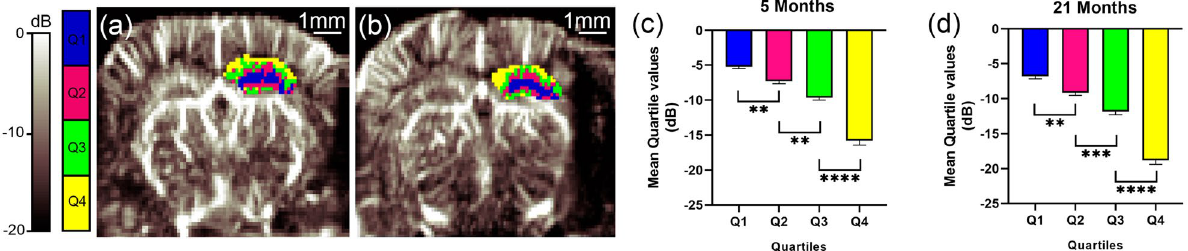
Figure 2. µ Doppler segmentation of the hippocampus. Coronal µ Doppler image in decibels (dB) of a ( a ) 5-month-old and ( b ) 21-month-old mouse. For the dB scale, the reference value was taken as the maximum intensity within left hippocampus. The right hippocampus is overlaid with the quartile distribution of the flow intensity. Blue, fuchsia, green and yellow corresponds to pixels within the quartiles Q1, Q2, Q3 and Q4, respectively. The mean quartiles values showed significant differences between all quartiles for ( c ) 5-month-old and ( d ) 21-month-old mice. For 5-months-old mice: F ( 3,44 ) = 3.911 ; [Q1 vs Q2]: p = 0.0056, [Q2 vs Q3]: p = 0.0019 and [Q3 vs Q4]: p < 0.0001. For 21-months-old mice, F ( 3,44 ) = 1.806; [Q1 vs Q2]: p = 0.0029, [Q2 vs Q3]: p = 0.0005, [Q3 vs Q4]: p < 0.0001. **p < 0.0021, ***p < 0.0002, ****p <